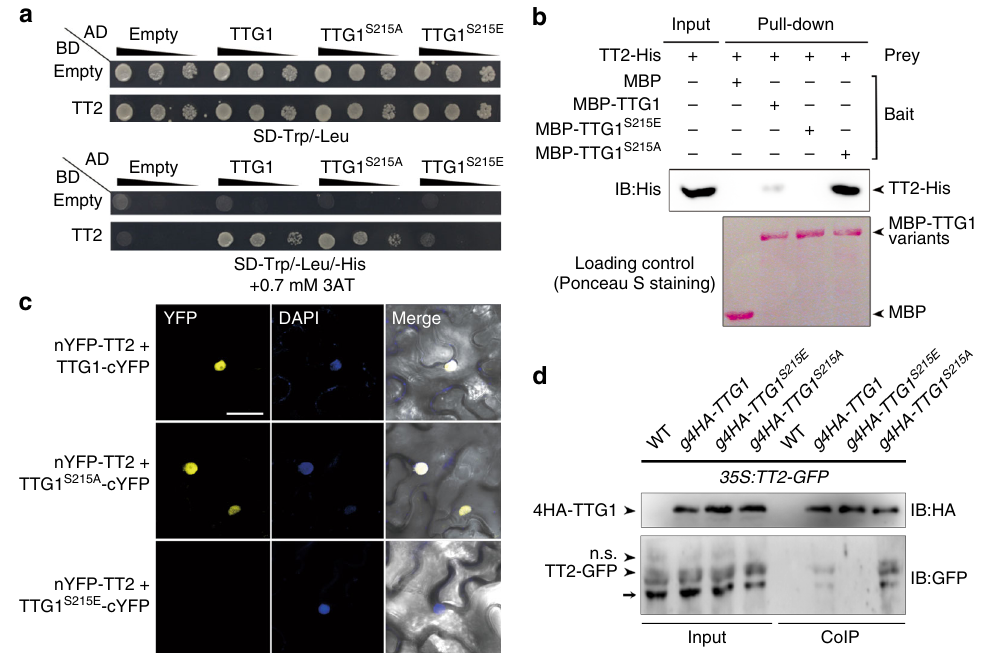
Fig. 6 Phosphorylation of TTG1 at Ser 215 abolishes its interaction with TT2. a Yeast two-hybrid assays show the interaction of TT2 with TTG1, its phosphorylation-mimicking mutant TTG1 S215E and dephosphorylation-mimicking mutant TTG1 S215A . Ten-fold serial dilutions of transformed yeast cells were grown on SD-Trp/-Leu medium (upper panel) and SD-Trp/-Leu/-His medium supplemented with 0.7 mM 3AT (lower panel). b In vitro pull-down assay of the interaction of TT2 with TTG1, TTG1 S215E , and TTG1 S215A . MBP, MBP-TTG1, MBP-TTG1 S215E , and MBP-TTG1 S215A were used as baits, and their loading amounts stained with Ponceau S are shown in the bottom panel. The input of the prey protein TT2-His and its corresponding pull-downed signals are shown in the upper panel. c BiFC analysis of the interaction of TT2 with TTG1, TTG1 S215E , and TTG1 S215A in tobacco epidermal cells. Yellow fl uorescence protein (YFP), fl uorescence of yellow fl uorescent protein; DAPI, fl uorescence of 4 ′ ,6-diamino-2-phenylindol; Merge, merge of YFP, DAPI, and bright fi eld. Scale bar, 50 μ m. d In vivo interaction between 4HA-TTG1 and TT2-GFP in Arabidopsis siliques shown by co-immunoprecipitation (CoIP). Total protein extracts from siliques of 35S:TT2-GFP in wild-type (WT), g4HA-TTG1 , g4HA-TTG1 S215E , or g4HA-TTG1 S215A background 4 days after pollination (DAP) were immunoprecipitated by anti-HA antibody. The input and co-immunoprecipitated proteins were subjected to immunoblot analysis with anti-HA (upper panel) or anti-GFP antibody (lower panel). The non-speci fi c (n.s.) signal and the potential degraded form of TT2-GFP are indicated by an arrowhead and an arrow, respectively. Uncropped original scans of immunoblots are shown in Supplementary Fig.